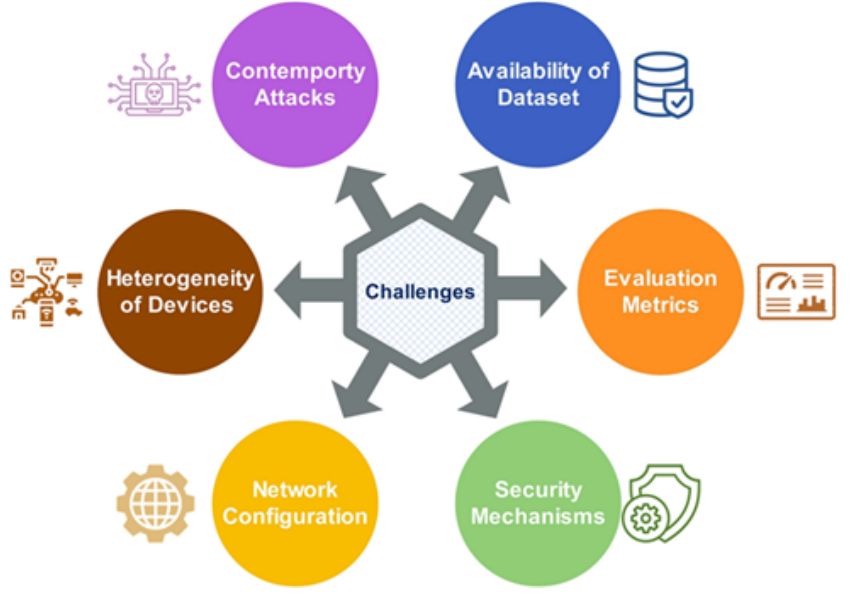
Figure 12. Issues and